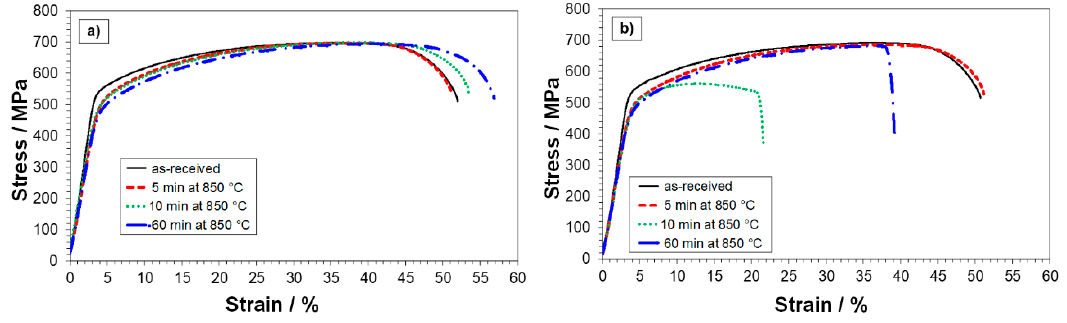
Figure 10. Stress—strain curves obtained with SSRT performed in air at 25 °C ( a ) and in NACE TM-0177 in the presence of 10 − 3 M S 2 O 32 − ( b ) on DSS 2304, both as-received and aged at 850 °C for 5, 10 and 60 min.